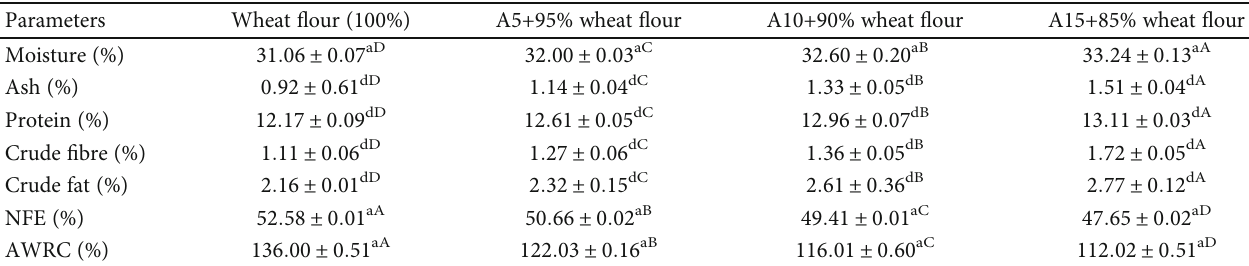
Table 6: E ff ect of substitution of amaranth fl our on proximate composition of bread. Parameters